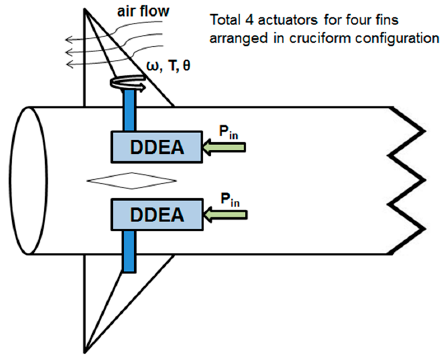
Figure 2. Schematic of the direct drive electric actuator, fin and missile (Level 1).